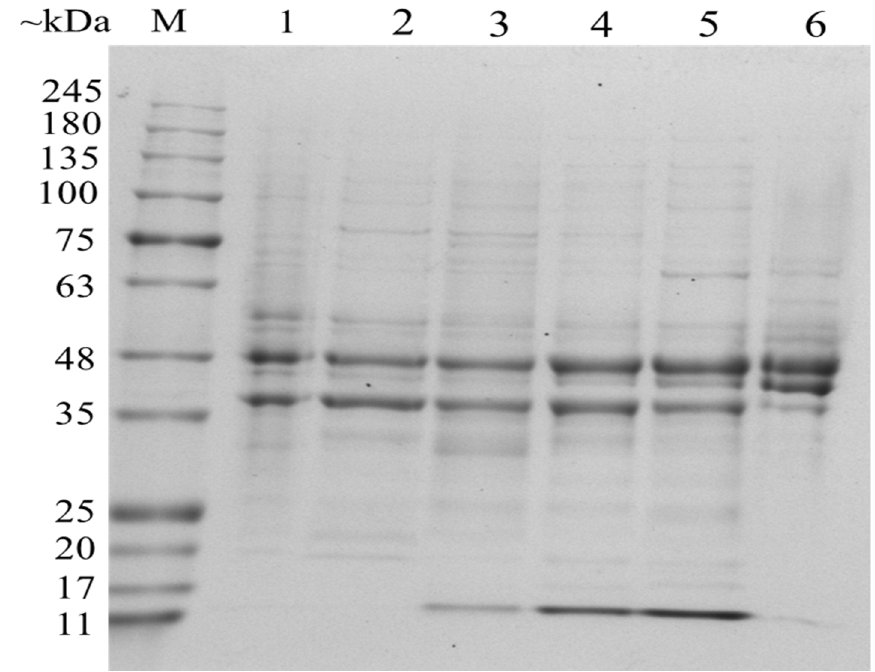
Figure 4. SDS-PAGE of OMPs of V. brasiliensis cultured in culture medium with different NaCl concentration. M: marker; lane 1, OMPs of V. brasiliensis cultured in 0% NaCl medium; lane 2, OMPs of V. brasiliensis cultured in 1% NaCl medium; lane 3, OMPs of V. brasiliensis cultured in 2% NaCl medium; lane 4, OMPs of V. brasiliensis cultured in 3% NaCl medium; lane 5, OMPs of V. brasiliensis cultured in 5% NaCl medium; lane 6, OMPs of V. brasiliensis cultured in 7% NaCl medium. Identification of differentially expressed OMPs was performed by mass